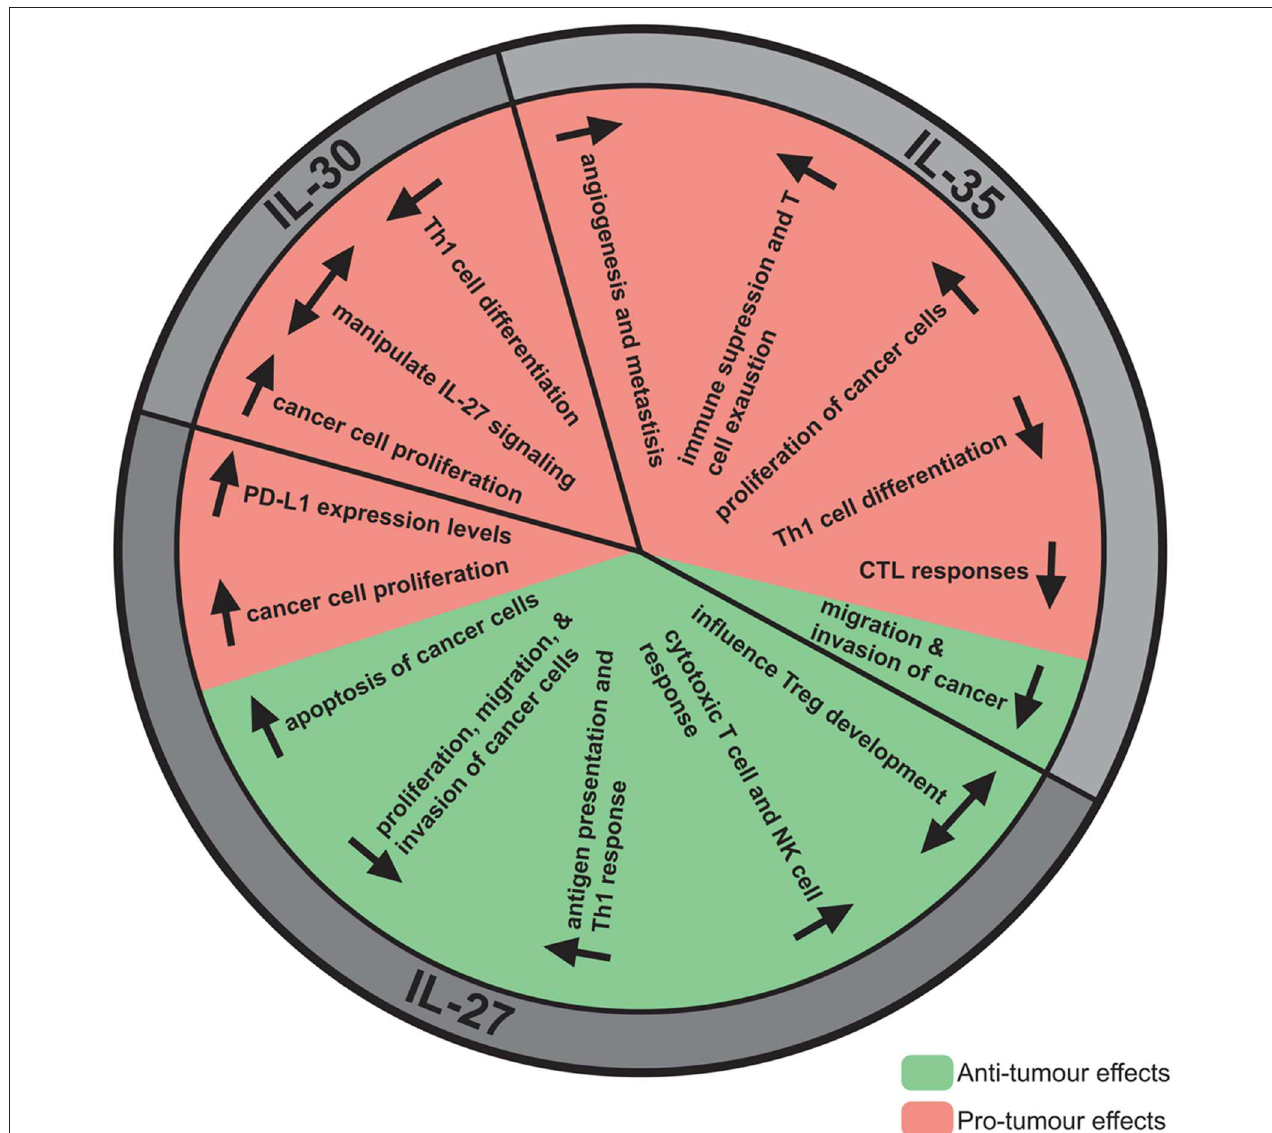
FIGURE 2 | The anti- and pro-tumor effects of IL-27, IL-30, and IL-35. Although IL-27, IL-30, and IL-35 share subunits, these cytokines have direct and indirect effects on the tumor resulting in either tumor progression or elimination. IL-27 has mainly been demonstrated to have anti-tumor effects, most notably decreasing proliferation, migration, and invasion, enhancing apoptosis, and promoting cytotoxic immune responses. Pro-tumor effects have also been observed for IL-27, such as upregulation of PD-L1. Alternatively, IL-30 has not been studied extensively but pro-tumor effects have been identified, such as promoting cancer cell proliferation, and decreasing Th1 differentiation. IL-35 has been implicated in promoting tumor advancement by increasing cancer cell proliferation, angiogenesis, metastasis, immune suppression, and T cell exhaustion. Contrastingly, IL-35 may have anti-tumor effects attributed to its potential role in decreasing cancer cell migration and